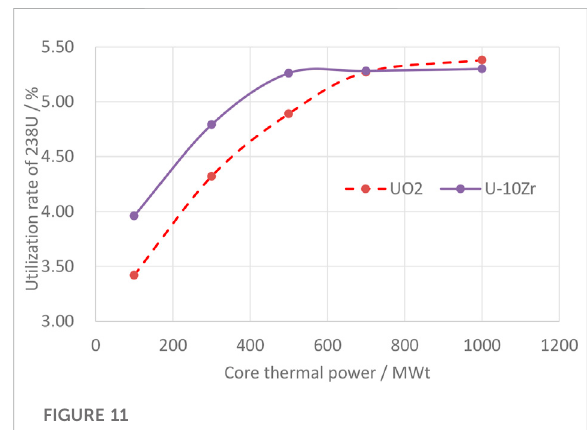
FIGURE 10 Utilization rate of 235U along with the core power level.